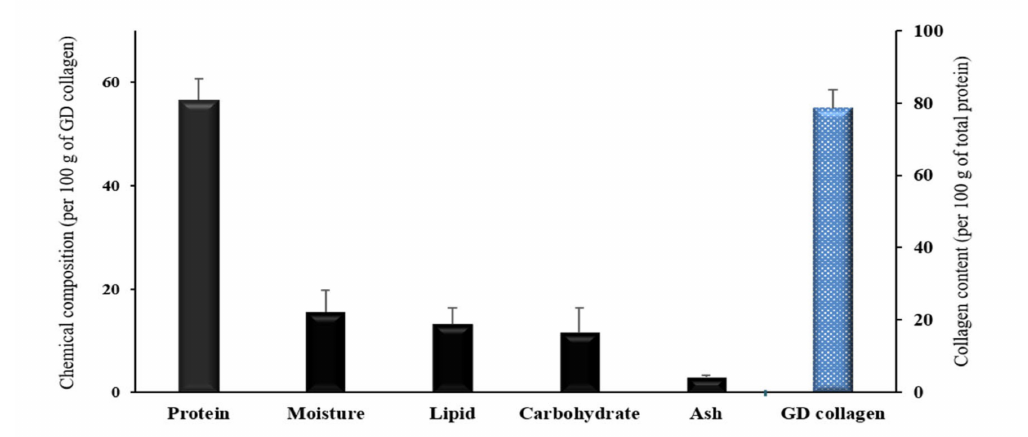
Figure 1. Proximate chemical composition and total collagen content of the Gallus domesticus (GD) collagen. Values are mean ± standard deviation of three measurements (n =